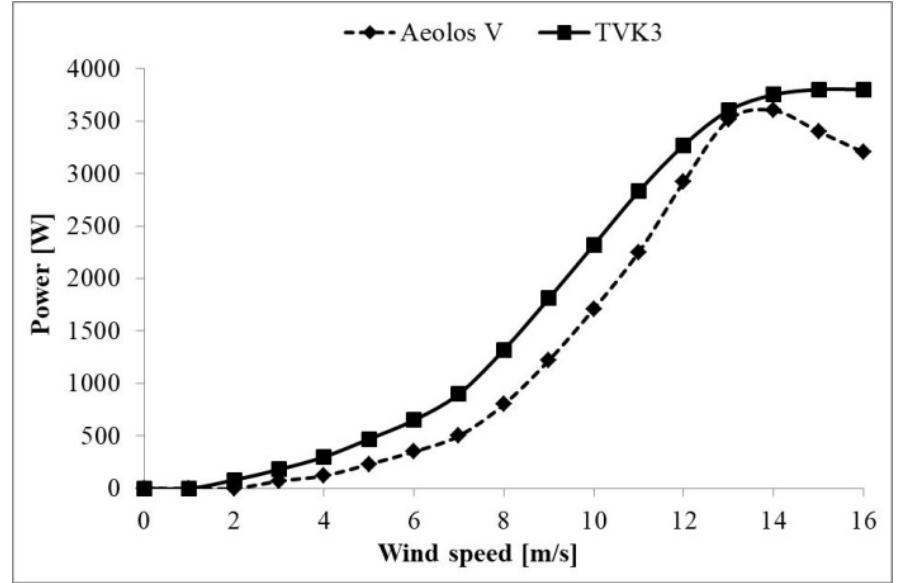
Figure 9. Turbine types selected for analysis ( a ) WT1, ( b ) WT2.